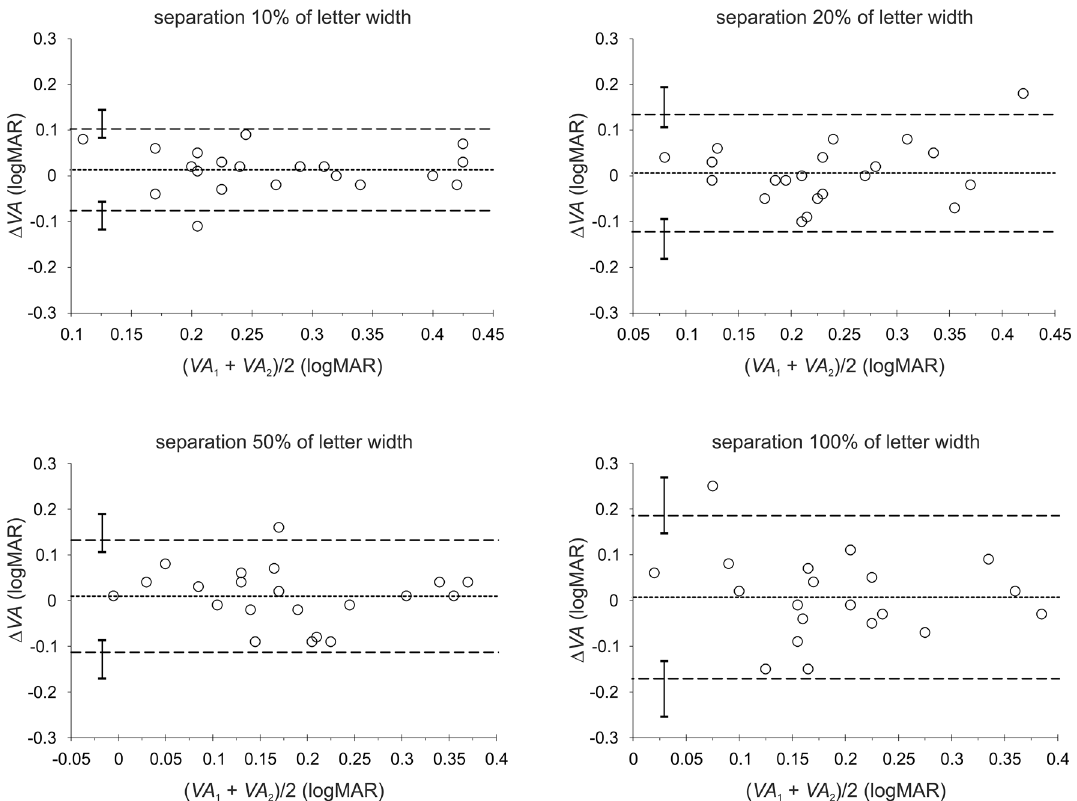
Figure 4. Bland and Altman 43 plots depicting the difference ∆ VA in logMAR between the first VA 1 (test) and second VA 2 (retest) measurements against their average for the low (− 5%) contrast level. The dashed lines represent the 95% limits of agreement (LoA) and the dotted lines the mean differences. The error bars shown in each panel represent the 95% confidence intervals for the Bland–Altman LoAs 44